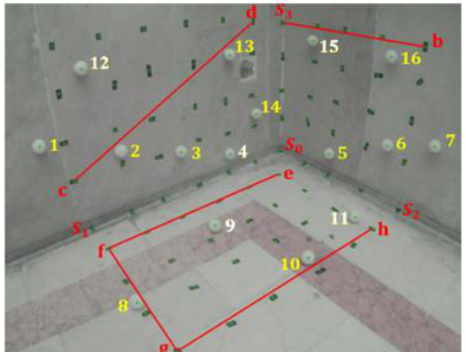
Figure 5. The test field provided for the calibration methods. The balls labeled with yellow numbers are control points used for estimating the calibration parameters and the check points are